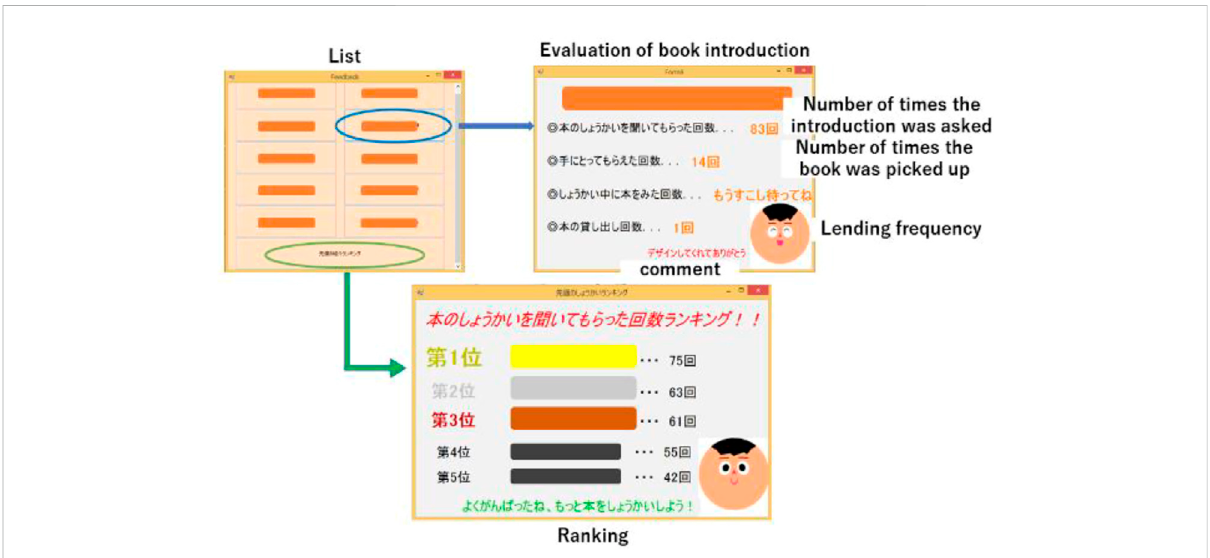
FIGURE 7 Feedback application. The upper left corner shows the number of times the book was introduced, picked up, or checked out. The lower fi gure shows the ranking of the number of book introductions viewed.